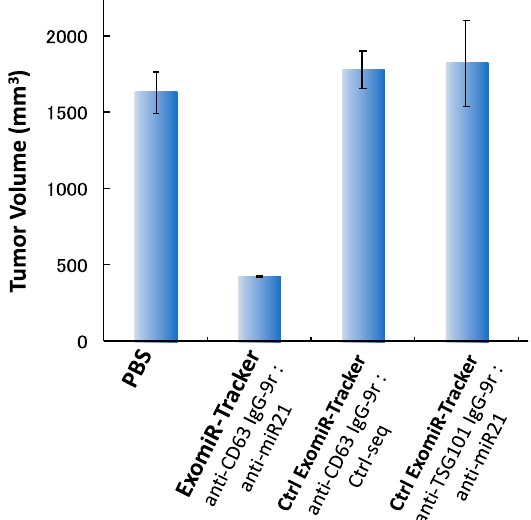
Figure 5. ExomiR-Tracker inhibited exosomal miR-21 function in vivo. Anti-tumorigenesis effects of ExomiR-Trackers in nude mice.